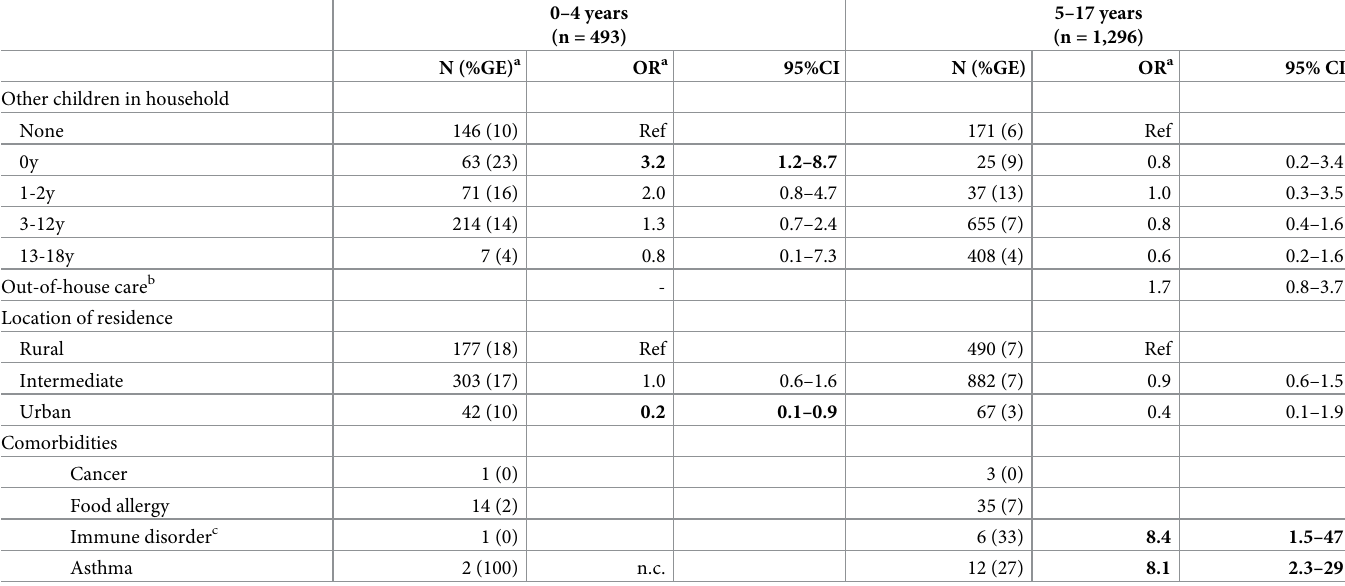
Table 2. Multivariable weighted logistic regression models of factors associated with gastroenteritis in children, stratified by age groups.